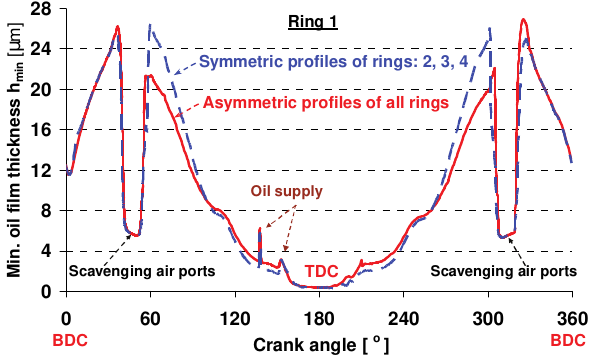
Fig. 14. Comparison of the oil film thickness h oil [ m m] left by the piston ring pack along cylinder wall in case of standard oil temperature and lower Fig. 12. Comparison of the minimum oil film thickness h min [ m m] of the 1 st oil temperature distribution on cylinder liner (top) piston ring in case of asymmetric profiles of all rings and symmetric profiles of rings 2, 3, 4